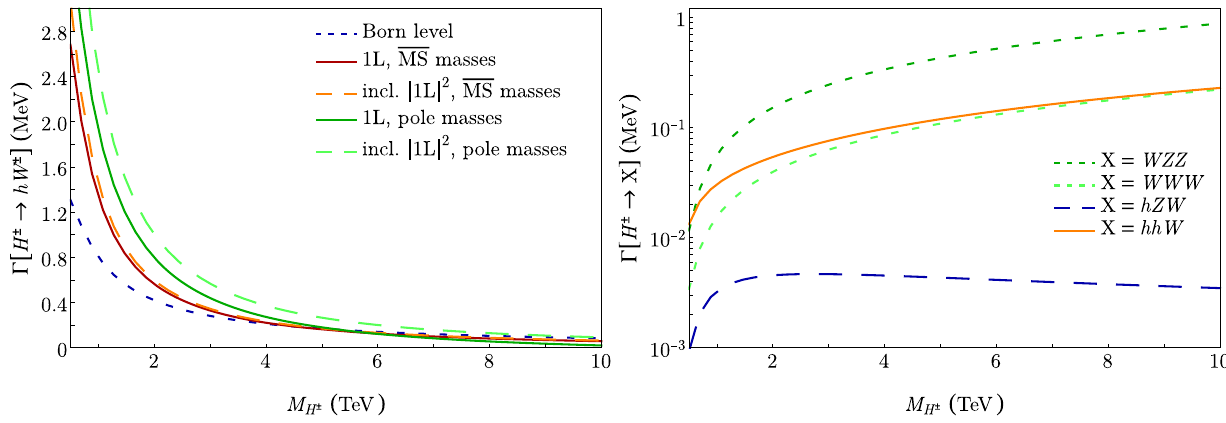
Fig. 8 Bosonic Higgs decays of the charged Higgs in the MSSM sce- nario of Sect. 2. Left: the two-body width (cid:6) [ H ± → hW ± ] is shown at tree level (dashed blue) and at 1L for two choices of schemes for the